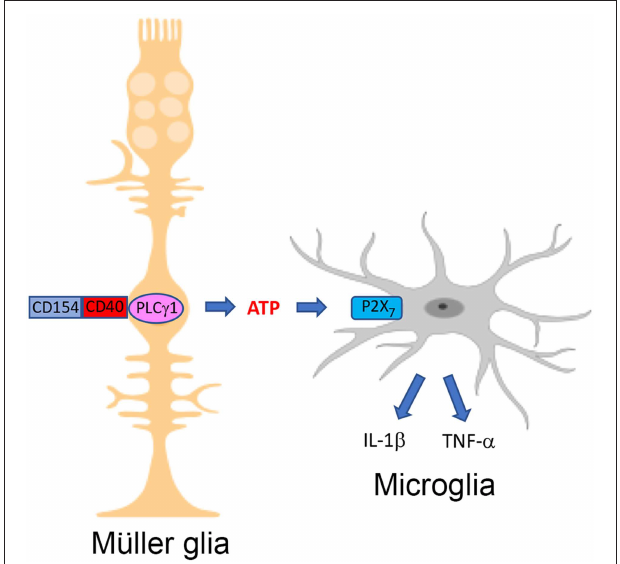
FIGURE 1 | The CD40-ATP-P2X 7 pathway links cellular responses in Müller glia with the induction of inflammatory responses in bystander microglia/macrophages in DR. Blood levels of CD154 and expression of CD40 in Müller glia are increased in diabetes. CD40 ligation in Müller glia causes PLC γ 1 (PLC) activation and secretion of extracellular ATP. P2X 7 receptor is upregulated in microglia/macrophages in the diabetic retina. ATP binds P2X 7 receptor leading to secretion of TNF- α and IL-1 β . Created in part with